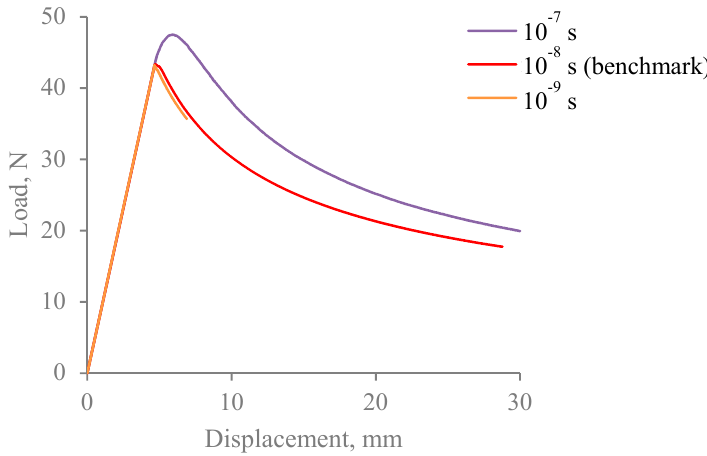
Figure 9. Parametric study with respect to the viscosity parameter.